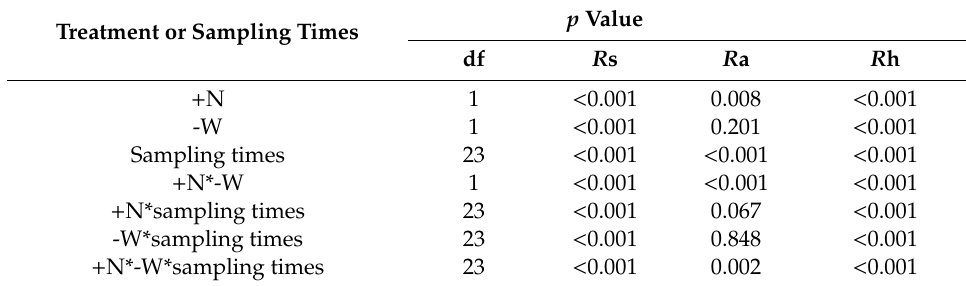
Table 1. Effects of different treatments and sampling time on nongrowing season soil respiration and its components.